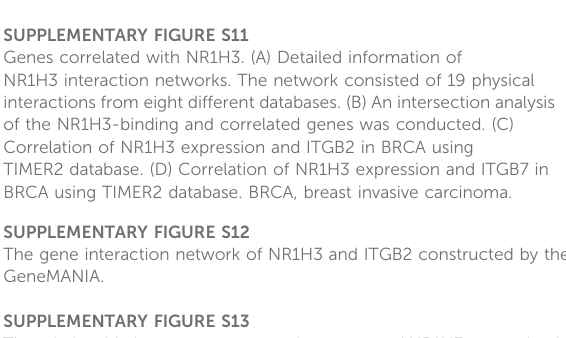
SUPPLEMENTARY FIGURE S3 The landscape of relation between NR1H3 expression and TILs in different cancer types available at TISIDB database. TILs, tumor- in fi ltrating lymphocytes. SUPPLEMENTARY FIGURE S4 The landscape of relations between NR1H3 expression and immune in fi ltration of B cells, CD4+ T cells, CD8+ T cells, monocytes, macrophages, DCs, neutrophils and NK cells across human cancers in the TIMER database. DCs, dendritic cells; NK, natural killer. SUPPLEMENTARY FIGURE S5 Correlation between NR1H3 expression and the TME. (A, B) Correlation analysis between the expression of NR1H3 in primary breast cancer tissues and the TME. TME, tumor microenvironment. SUPPLEMENTARY FIGURE S6 Correlationandprognosticef fi ciencyofmacrophagein fi ltrationacross multiple cancer types. (A) Correlation between NR1H3 expression and gene markers of monocyte/macrophage across multiple cancer types. (B) The clinical relevance of the combination of in fi ltrated macrophages and NR1H3 expression patterns across multiple cancer types. SUPPLEMENTARY FIGURE S7 Assessment of association between the combination of immune in fi ltrates and NR1H3 expression patterns and clinical outcome across diverse cancer types. SUPPLEMENTARY FIGURE S8 Kaplan-Meier curves for NR1H3 expression level and monocyte/ macrophage in fi ltration using multiple algorithms in BRCA (A), basal subtype (B), luminal A subtype (C) and luminal B subtype (D). BRCA, breast invasive carcinoma. SUPPLEMENTARY FIGURE S9 The landscape of relationship between NR1H3 expression and immunoinhibitors (A), immunostimulators (B), MHC molecules (C), chemokines (D) and chemokine receptors (E) across human cancers. SUPPLEMENTARY FIGURE S10 Correlation of NR1H3 expression and PD-1/CD274, PD-L1/PDCD1, PD- L2/PDCD1LG2, and CTLA-4 across diverse human cancers. SUPPLEMENTARY FIGURE S11 Genes correlated with NR1H3. (A) Detailed information of NR1H3 interaction networks. The network consisted of 19 physical interactions from eight different databases. (B) An intersection analysis of the NR1H3-binding and correlated genes was conducted. (C) Correlation of NR1H3 expression and ITGB2 in BRCA using TIMER2 database. (D) Correlation of NR1H3 expression and ITGB7 in BRCA using TIMER2 database. BRCA, breast invasive carcinoma. SUPPLEMENTARY FIGURE S12 The gene interaction network of NR1H3 and ITGB2 constructed by the GeneMANIA. SUPPLEMENTARY FIGURE S13 The relationship between gene mutation status and NR1H3 expression in breast cancer. (A) The relationship between FBXW7 and NR1H3 expression in breast cancer was veri fi ed using GEPIA database. (B) The relationship between TMPRSS15 and RGS22 gene mutation